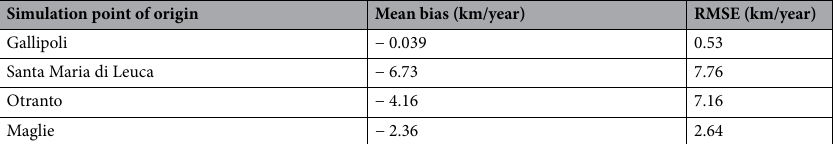
Table 6. Mean bias and root-mean-square error of the Puglia sampling strategy simulation with a logistic function for different points of origin of the simulated disease spread and fitted with Gallipoli as assumed origin (see Supplementary Analysis 3). RMSE root-mean-squared error. Bias is the average difference between the estimated value and the true value of the rate of movement of the front in